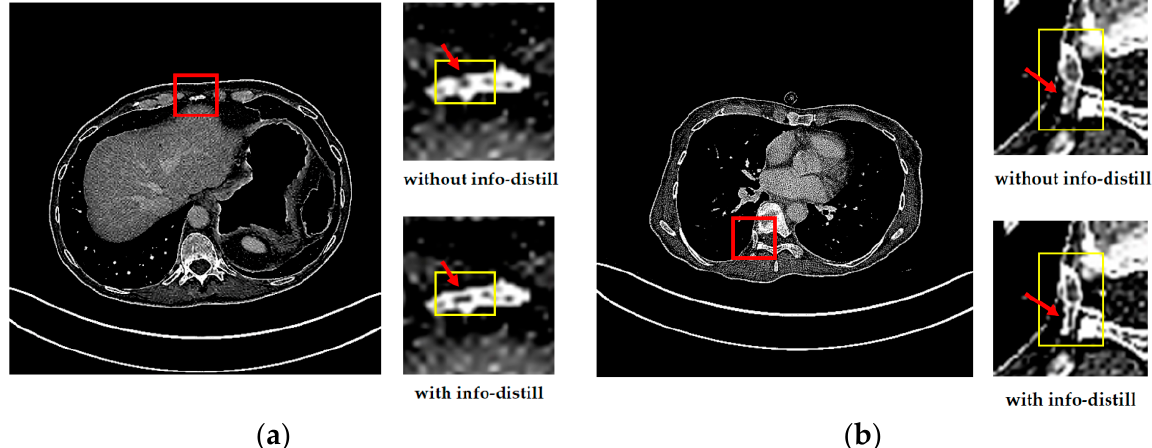
Figure 5. The reconstructed results of IDMAN with/without information distillation. ( a ) A reconstructed image of clear edges; ( b ) A reconstructed image of accurate details.